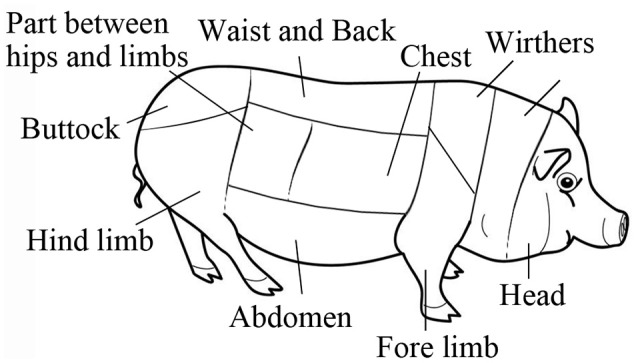
Body skin map of a swine.